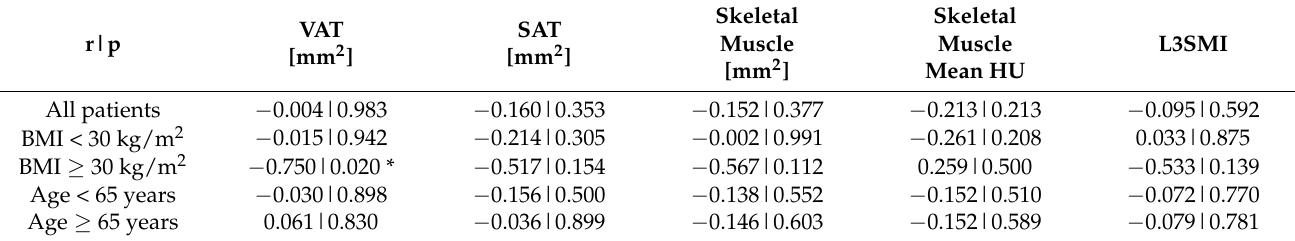
Table 4. Correlations between PLIN2 serum levels and CT-scan body composition